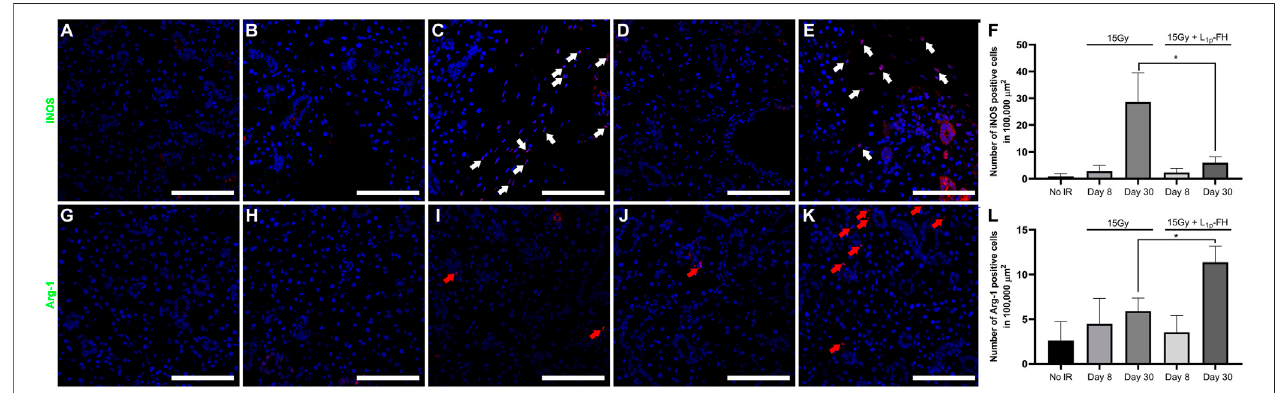
FIGURE4| L 1p -FHpromotesmacrophagepolarization. Macrophage markerexpression wasanalyzed using confocalmicroscopywithspeci fi cantibodies against iNOS (A – F) , Arg-1 (G – L) , and DAPI (blue; everywhere). Scale bars represent 100 µm. White and red arrows indicate iNOS or Arg-1 positive cells, respectively. Representative image from a total of fi ve mice per group. iNOS (F) and Arg-1 (L) positive cells were analyzed using ImageJ and GraphPad Prism 6. Data represent the means ± SD of n (cid:1) 5 mice per condition with statistical signi fi cance assessed using one-way ANOVA (* p < 0.01) and Dunnett ’ s post-hoc test for multiple comparisons to group 2 (irradiated with no L 1p -FH injection at day 30).